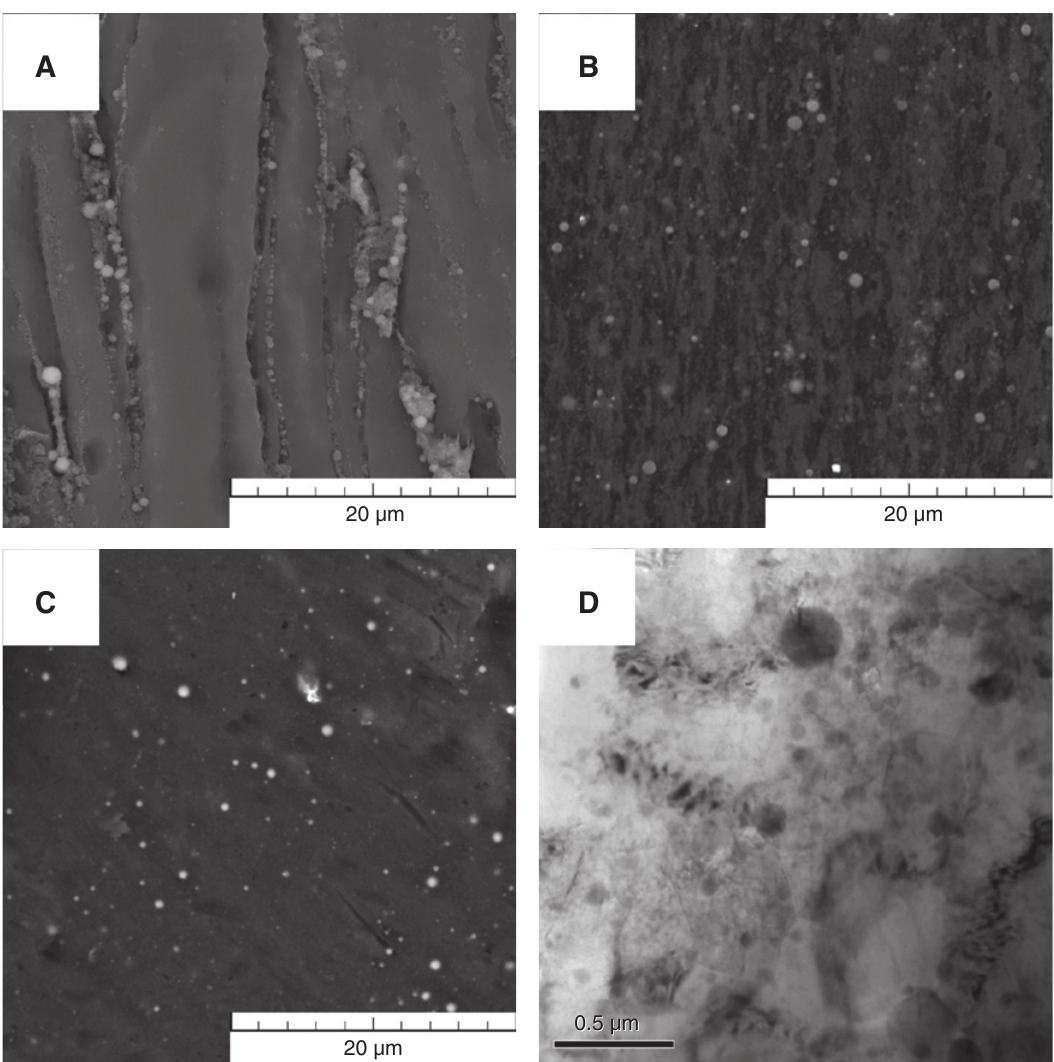
Figure 3: Mg-5HA extruded at 400 ° C with previous (A) mixing in hexane and (B) mixing in planetary mill. (C) Homogenously distributed HA particles in Mg after milling. (D) Structure of Mg-5HA after extrusion at 400 ° C